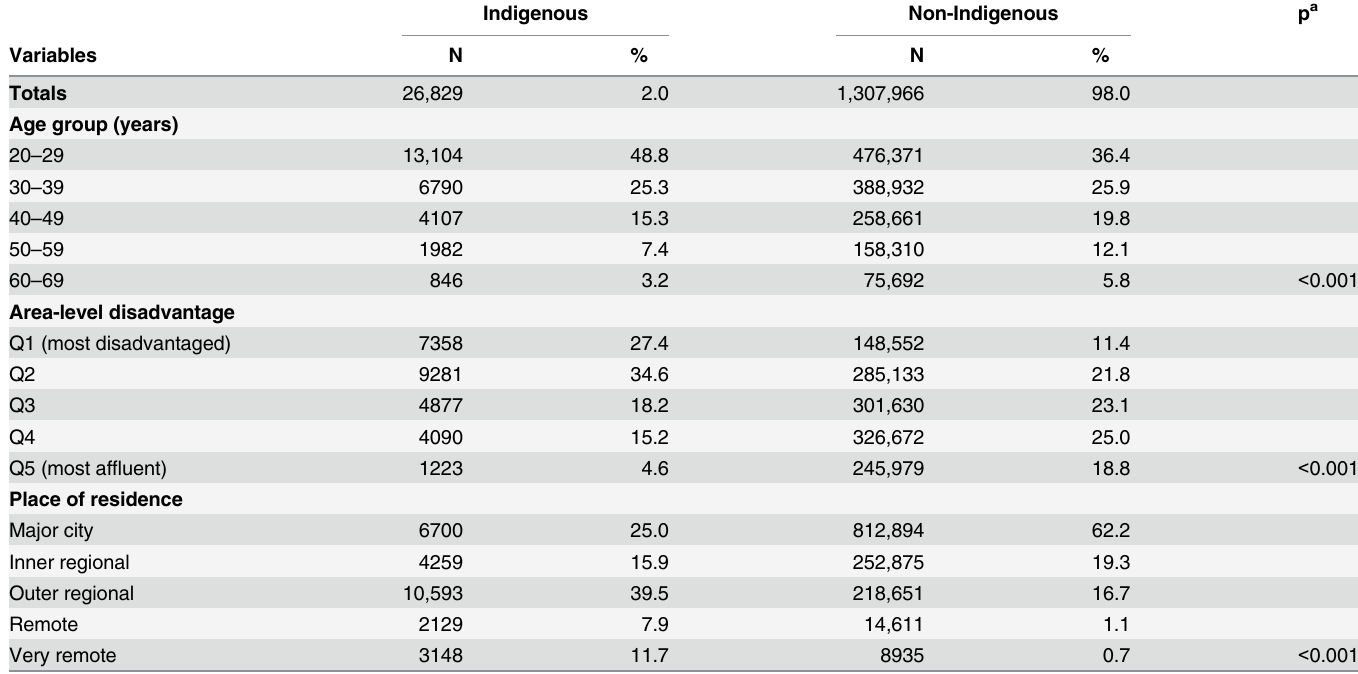
Table 1. Characteristics of Indigenous and non-Indigenous women at their first recorded Pap